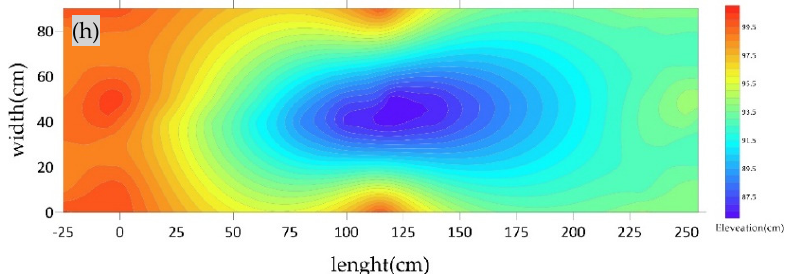
Figure 3. Laboratory set up. ( a ) The vegetation elements and prefabricated wooden templates, ( b ) instantaneous velocity measurements using an ADV, ( c ) the tool for topographical bed survey, ( d ) side view of the riffle-pool-riffle bedform, ( e ) the irregular array pattern of vegetation elements with ∅ = 7 × 10 − 3 , ( f ) ∅ = 4.7 × 10 − 3 , ( g ) ∅ = 2.3 × 10 − 3 , and ( h ) bed topographic contours. Note: the green-color circles are vegetated elements and red-color rectangles represent the location of the velocity measurements.